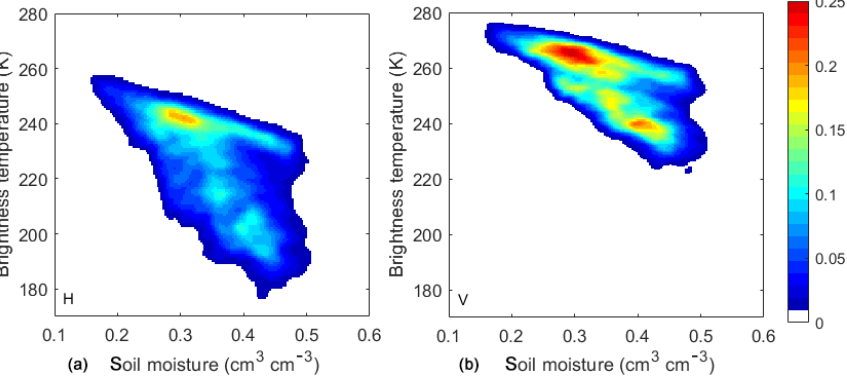
Figure 9. Scatter plots of the joint PDF between brightness temperature at H (a) and V (b) polarization against soil moisture computed from the 400m resolution virtual reality for 1 year. Both the temporal and spatial variation is included.